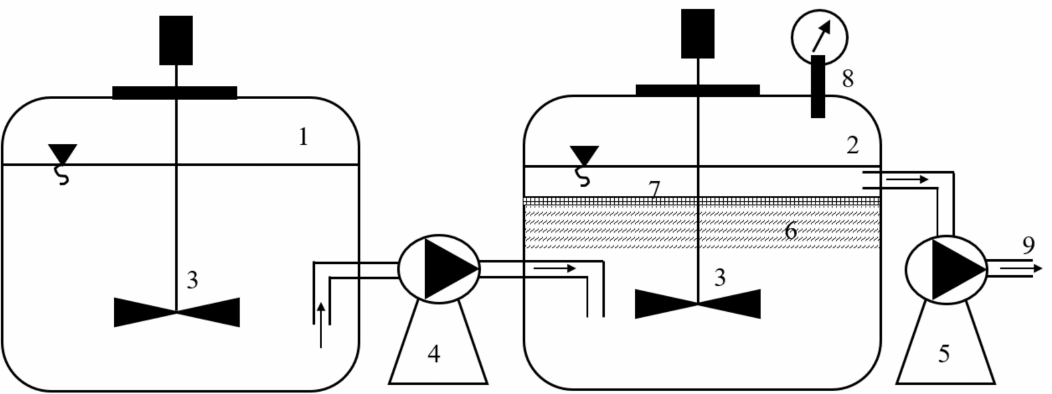
Figure 2. A diagram of the experimental process system (1—hydrolysis tank, 2—fermentation tank, 3—agitators, 4—rotary lobe pump, 5—peristaltic pump, 6—magneto-active filling, 7—limiting grid, 8—biogas outflow with a meter, 9—outflow of treated e ffl